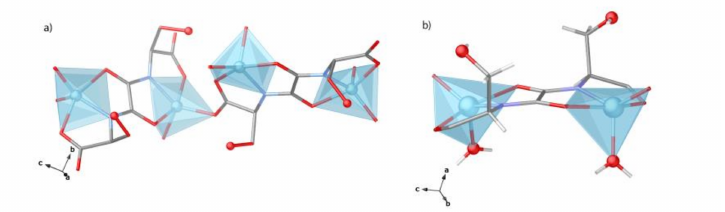
Figure 2. Perspective view of a fragment of 1 emphasizing the central dinuclear Zn 2 SBU ( b ) unit and their connection to neighboring Zn 2+ cations ( a ). Color code: Zn, O, and N atoms are represented as cyan, red, and deep blue spheres, respectively, whereas C atoms are depicted as grey